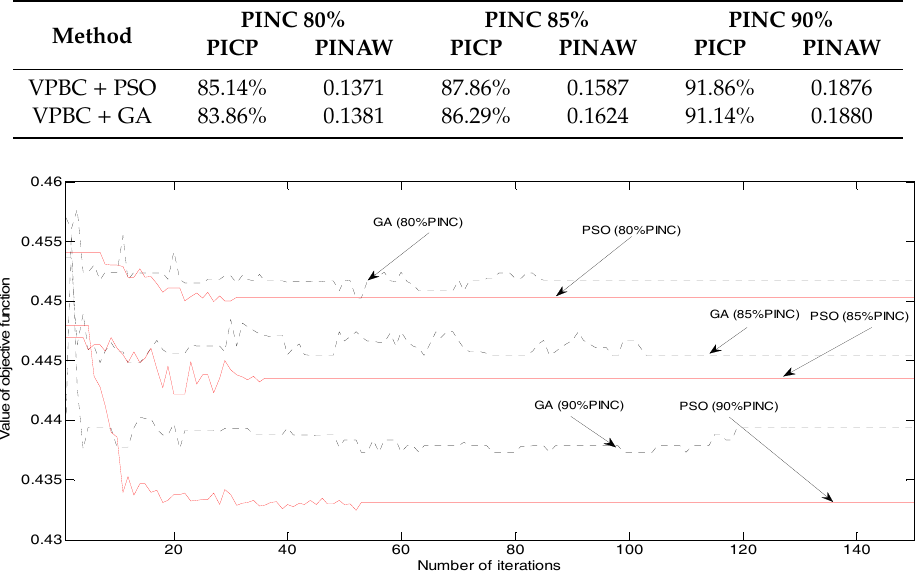
Table 3. Comparison of the performance indicators for wind power interval forecasting using PSO and GA optimization. GA: genetic algorithm.